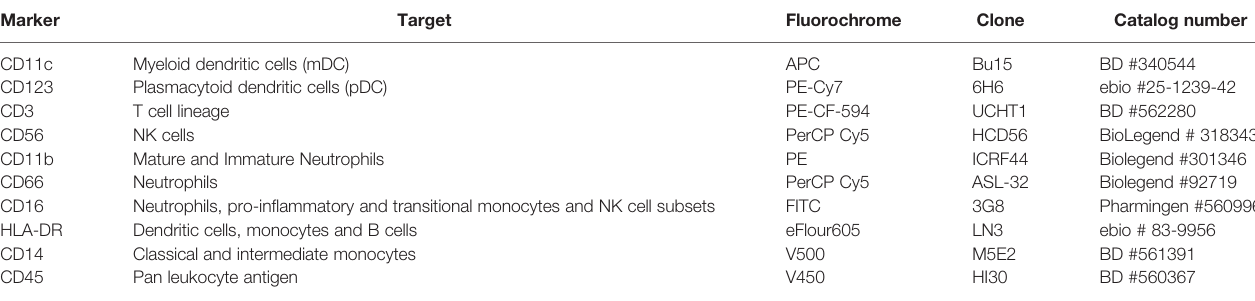
TABLE 3 | Antibody panel for cell sorting for single cell RNA sequencing.